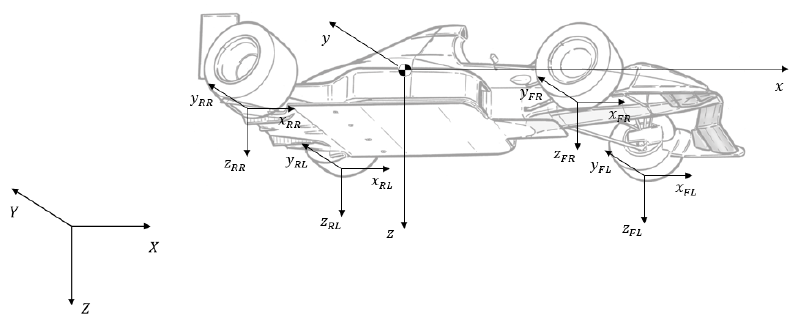
Figure 1. Reference